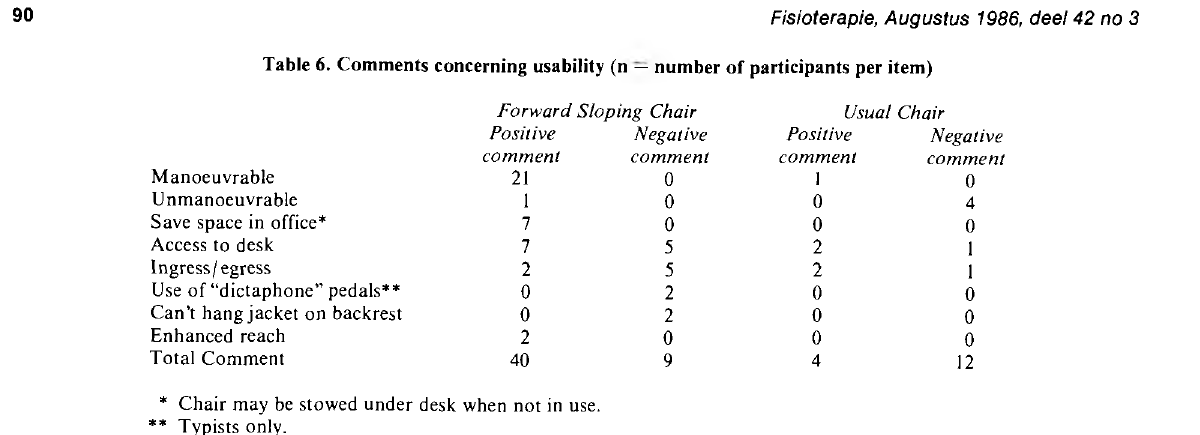
Table 6. Comments concerning usability (n — number of participants per item) Forward Sloping